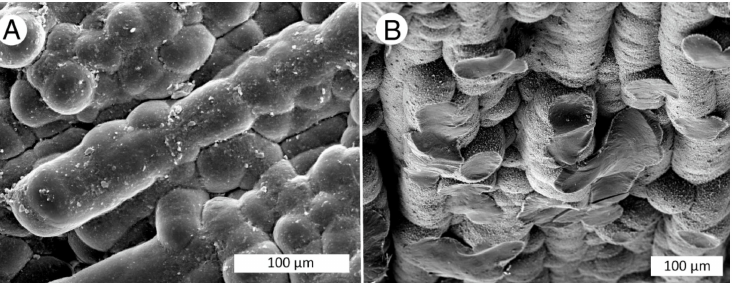
Figure 8. Development of incipient crystallization in Miocene fossil wood. ( A ) Wood fibers mineral- ized with opal-A. Gerlach, Nevada, USA. ( B ) Cells showing incipient opal-CT crystallization. The interior regions consist of vitreous opal; incipient crystallization textures are faintly visible on the outer surface of each sell, Northwest Iran, Specimen courtesy of Nasrollah